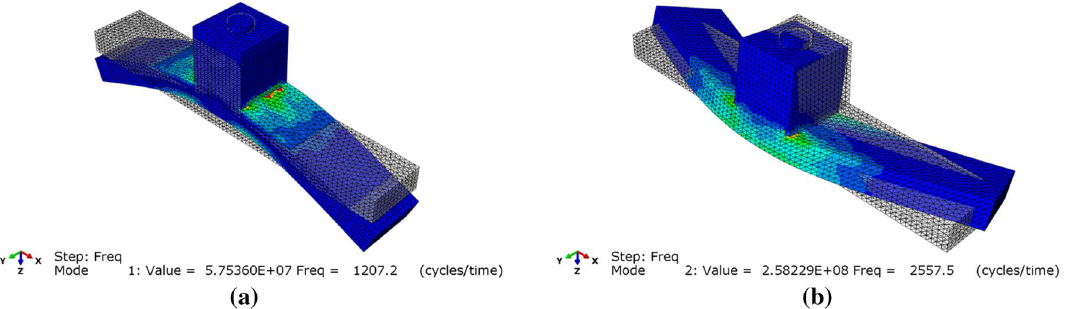
Fig. 3 Strain energy distribution in the structure in the a first and b second mode of